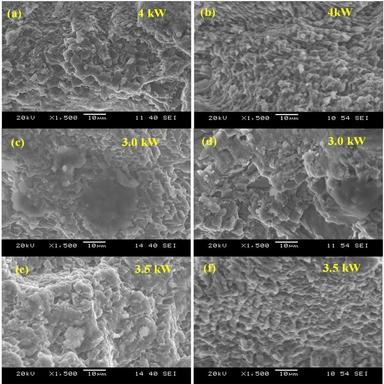
Fracture surfaces of (a) base material (AA 6082), (b) other side of the base material fracture surface, (c) aluminum side of 3 kW joint, (d) galvanized steel side of 3 kW, (e) aluminum side of 3.5 kW joint joint and (f) galvanized steel side of 3.5 kW joint.